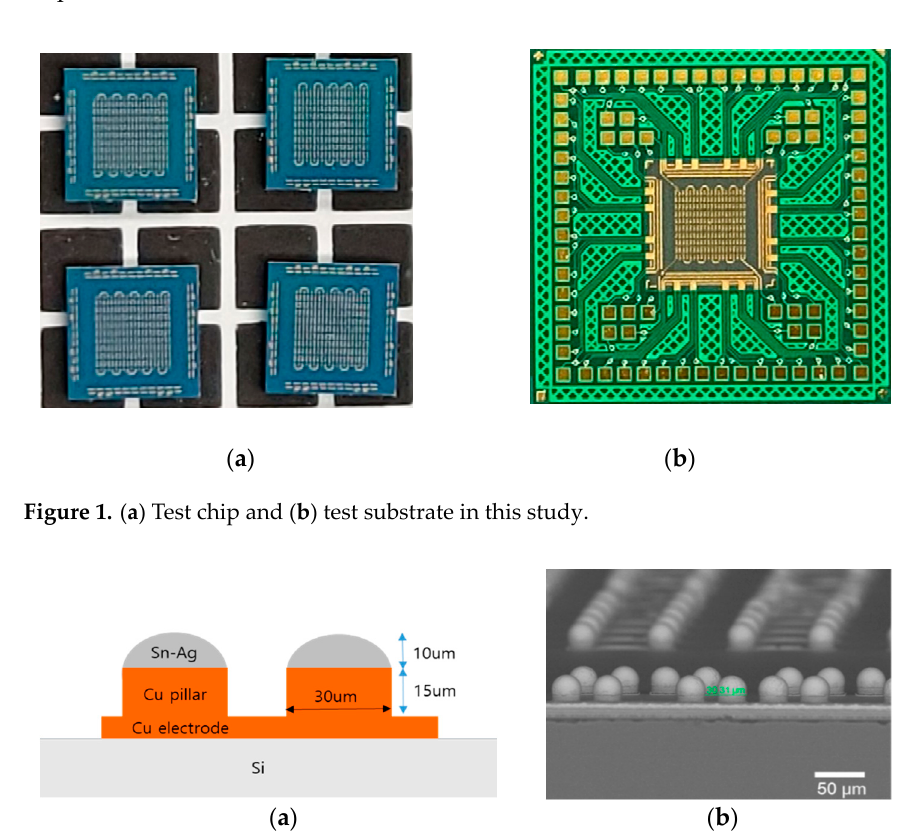
Figure 2. ( a ) Schematic and ( b ) SEM micrograph of Cu/SnAg pillar bump.